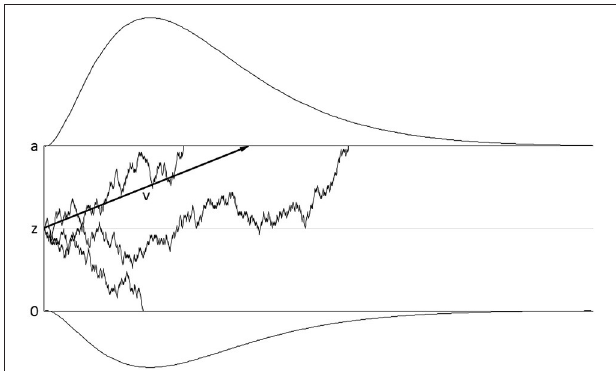
FIGURE 1 | Illustration of the basic diffusion model. Time passes from left to right. The upper and lower thresholds represent the amount of evidence necessary to select one or the other response alternative, respectively. The upper threshold corresponds to the correct response alternative, the lower threshold to the wrong response alternative. Evidence accumulation starts at starting point z and continues until one of the thresholds is reached. Evidence accumulation is influenced by random noise; the average rate of evidence accumulation (drift rate ν ) is shown by the black arrow. The drifts of three individual trials are shown. Reaction time is a linear function of the duration of the drift process; reaction time distributions for the correct and wrong response alternative are illustrated above and below the